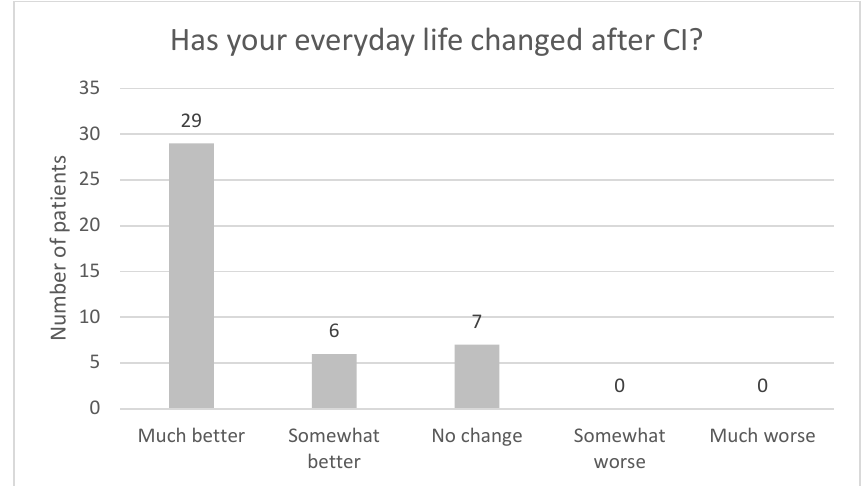
Figure 8. Has your everyday life changed after CI?